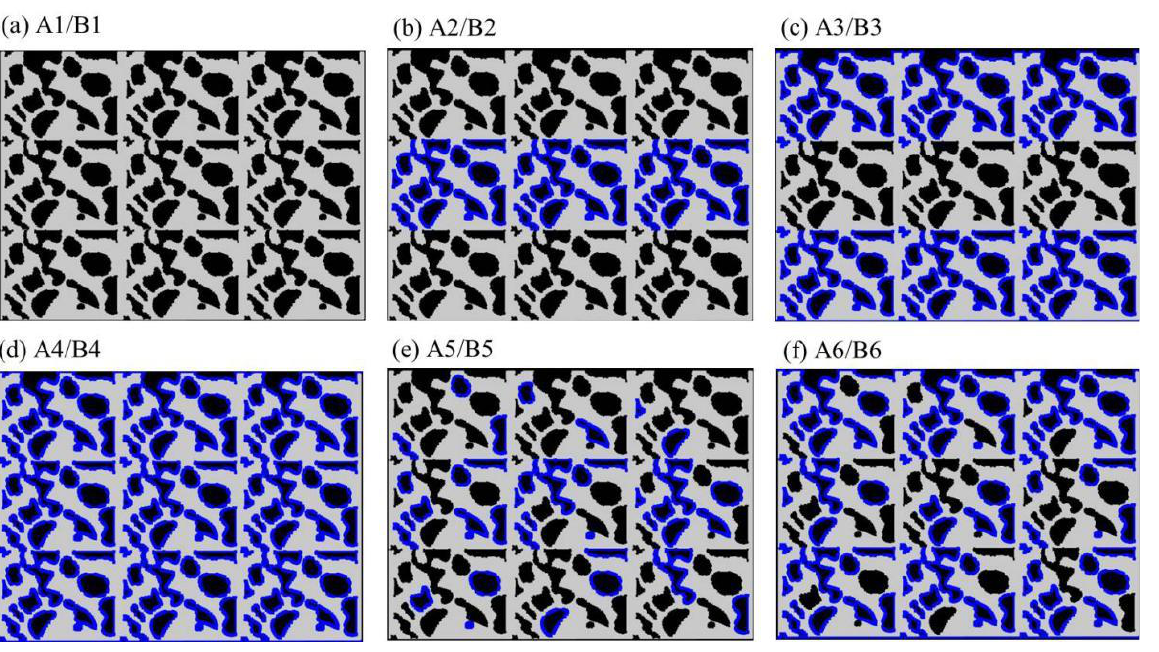
Figure 3. Wettability distribution used in the simulations; the blue walls are gas- wet (θ = 120 °), and the black walls are water-wet ( θ = 65.5°).